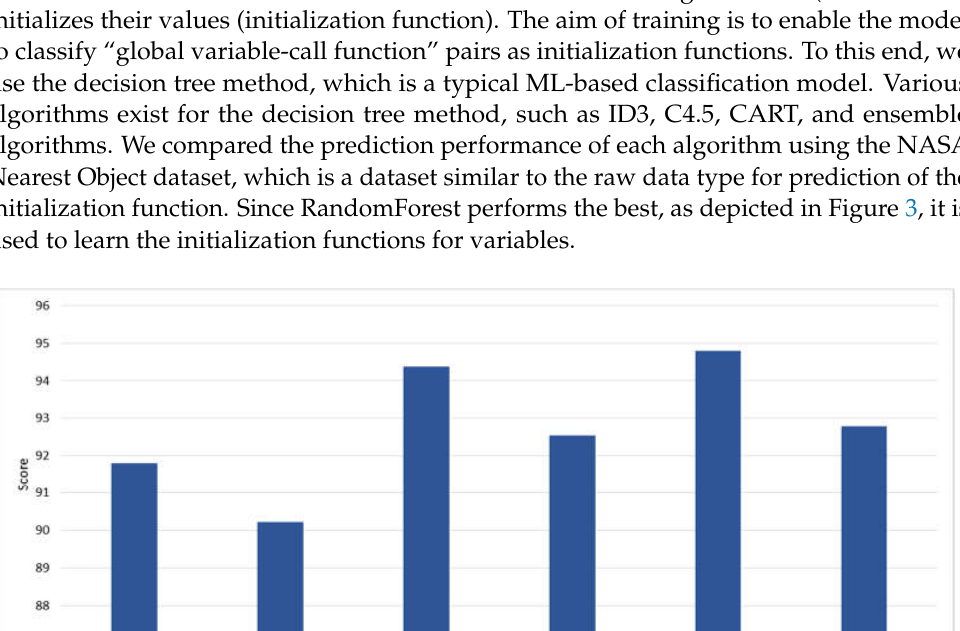
Figure 2. Static Analysis Process.